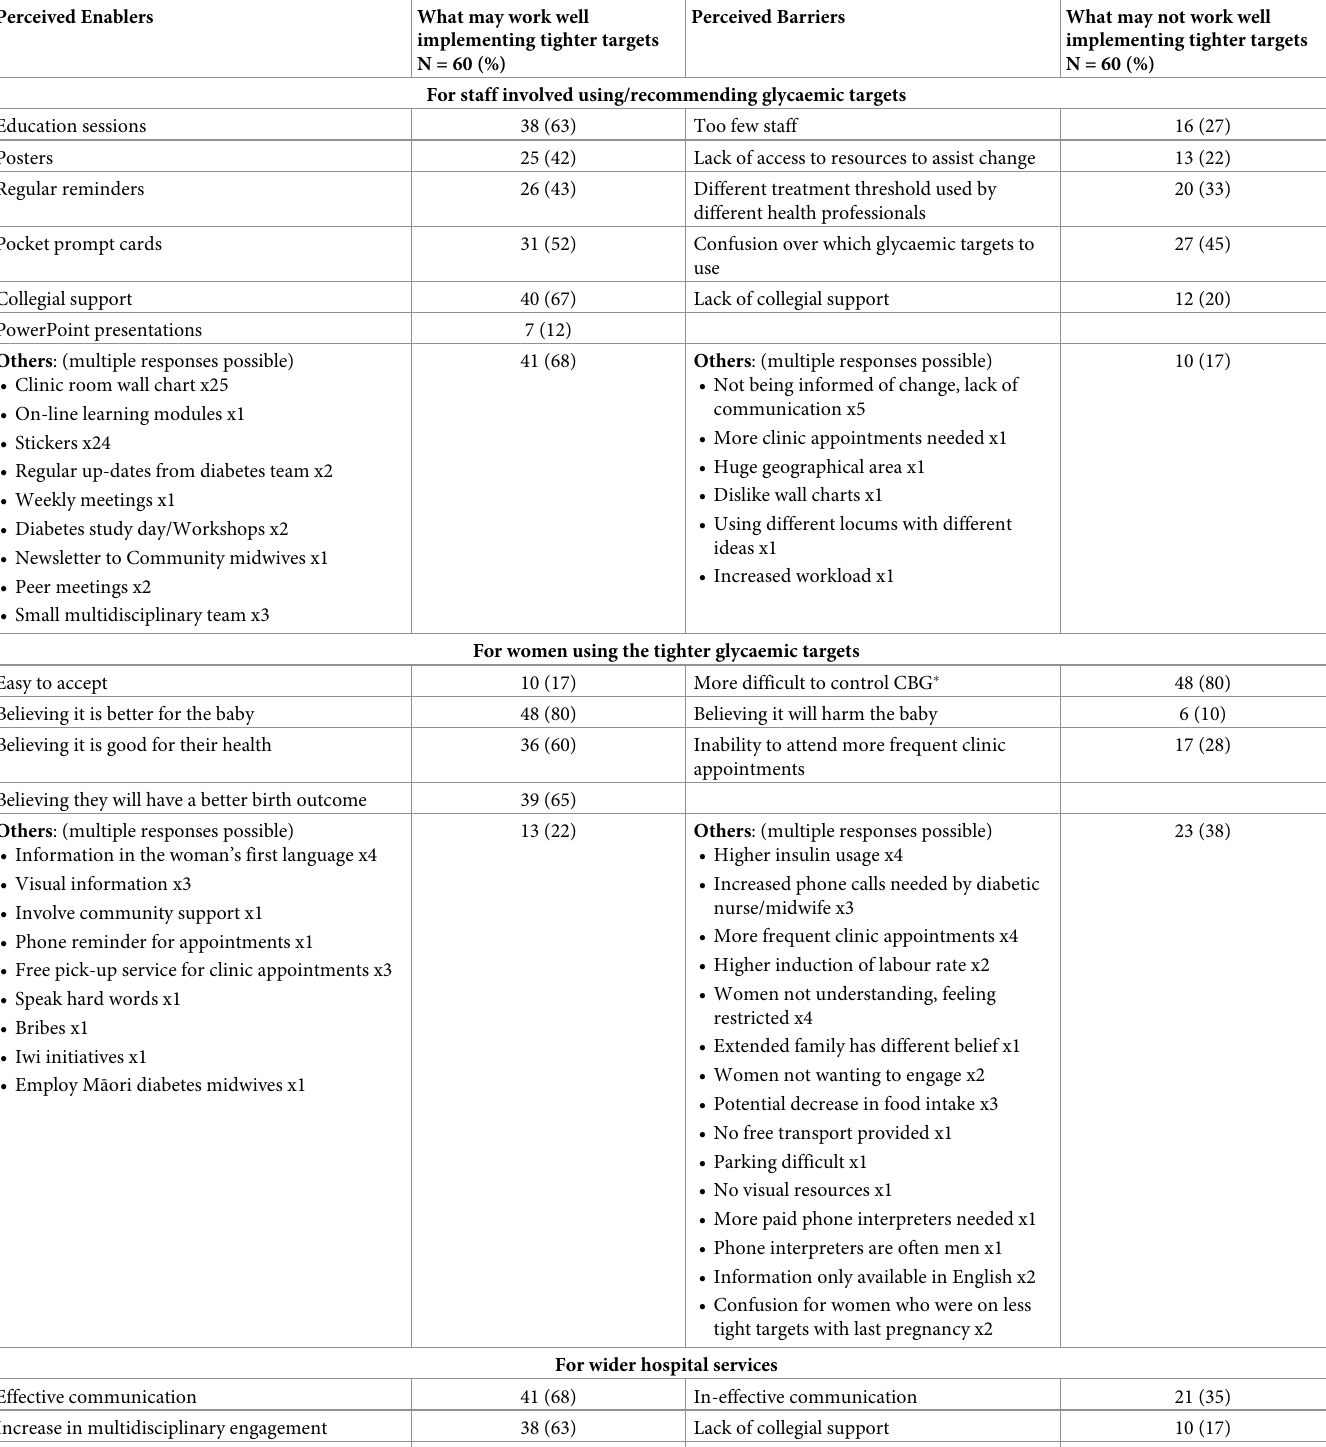
Table 3. Perceived enables and barriers to implement tighter glycaemic treatment targets among Key Informant Health Professionals providing care for women with GDM # . Perceived